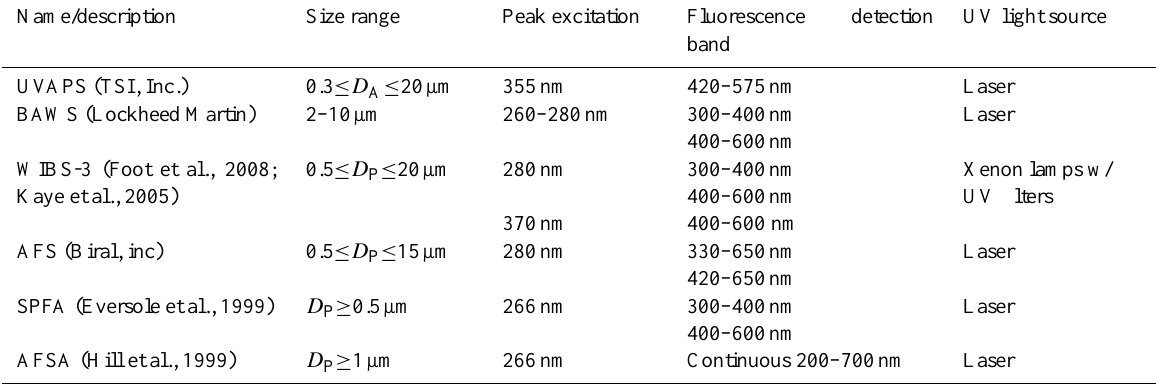
Table 1. omparison of some currently available UV-LIF bioaerosol